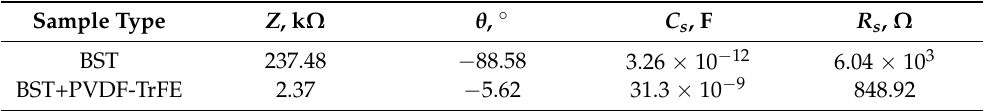
Table 1. Comparison of the main parameters measured by impedance spectroscopy for the pure BST and hybrid PVDF-TrFE/BST/PVDF-TrFE samples.